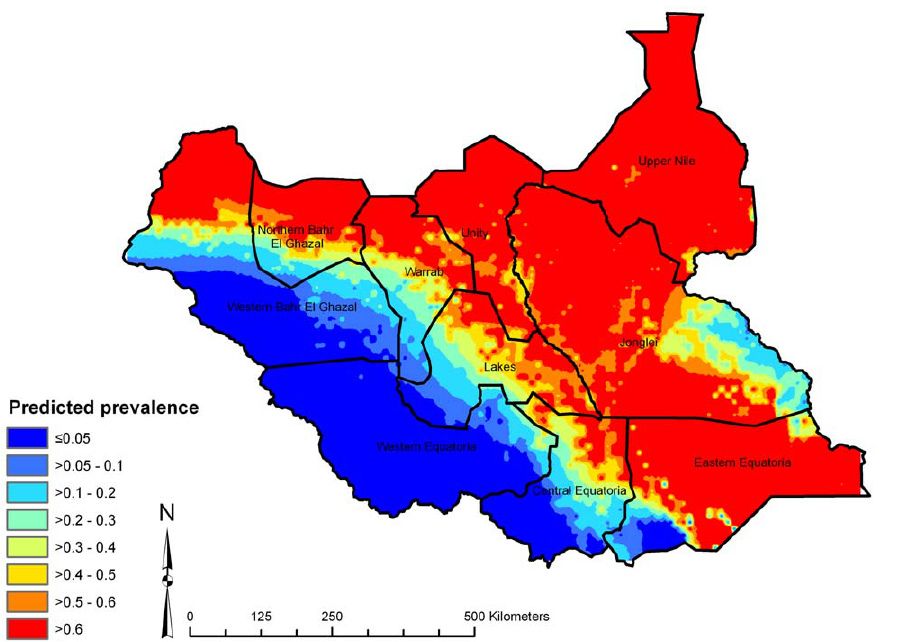
Figure 3. The median of the posterior distribution for predicted prevalence of active trachoma in children aged 1–9 years, Southern Sudan,